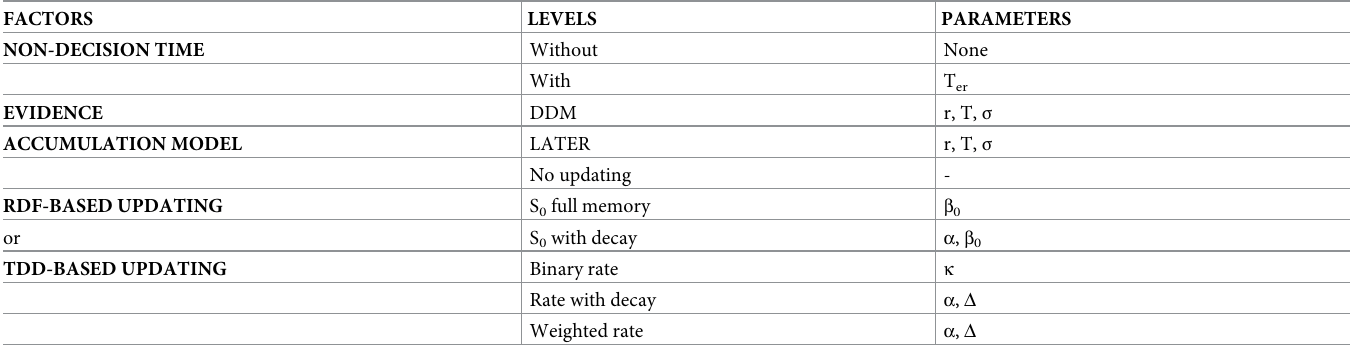
Table 1. A list of the levels and the associated parameters for each of the four